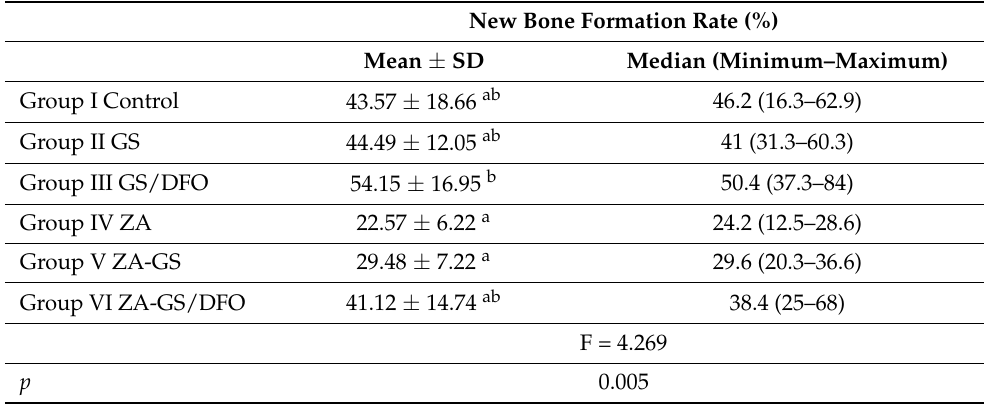
Table 3. Comparison of the new bone formation ratio values of the extraction sockets.